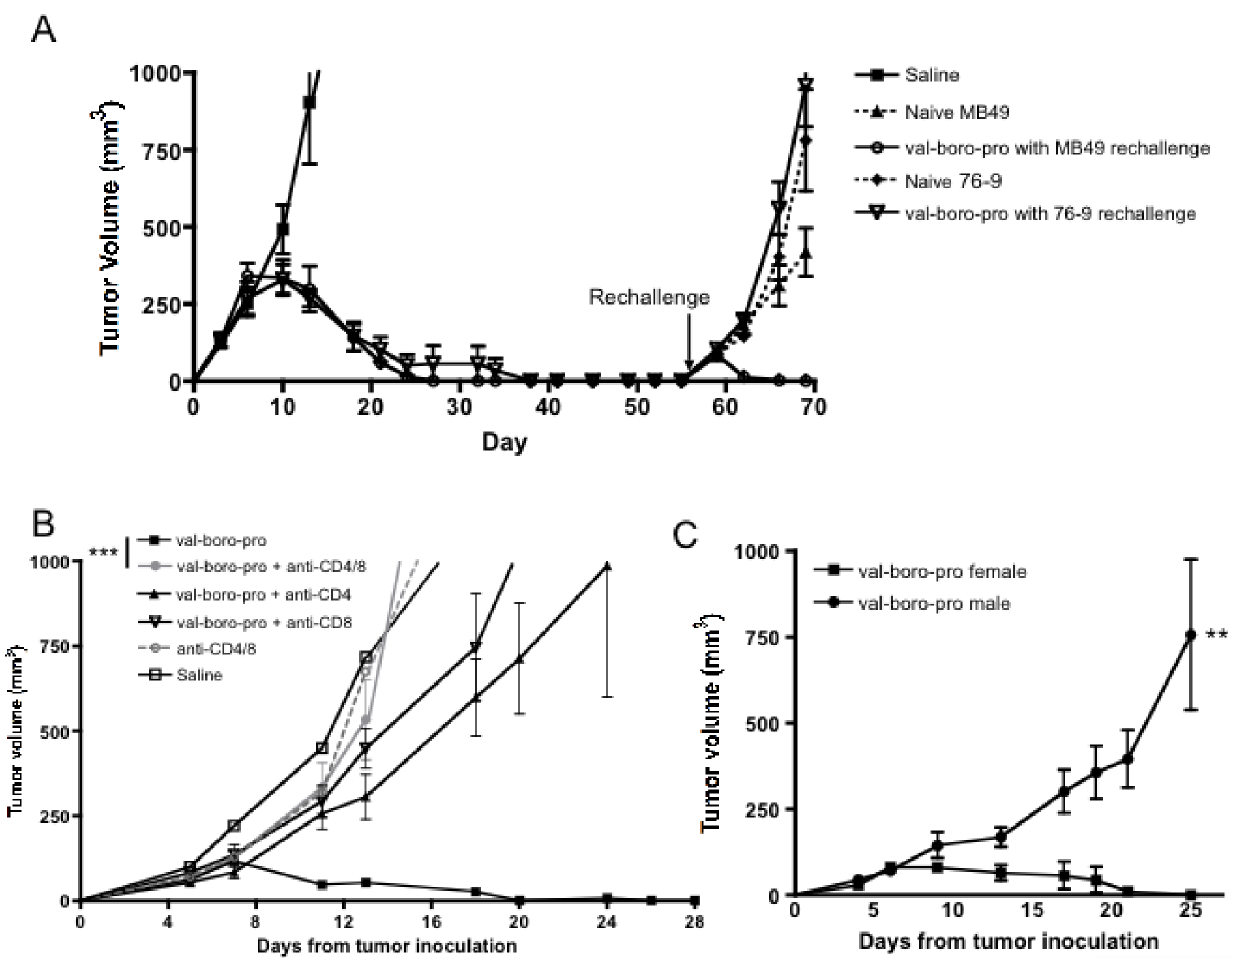
Figure 2. Val-boroPro mediated tumor regression is T cell dependent. (A) Female C57BL/6 mice were challenged on day 0 with 1 6 10 6 MB49 and treated with 20 m g Val-boroPro during weeks 1 through 4 (5 6 per week). Mice that were treated with 20 m g Val-boroPro and subsequently rejected MB49 were then rechallenged with MB49 (1 6 10 6 ) or 76-9 rhabdomyosarcoma (5 6 10 5 ) on day 56 post-primary challenge (n=5/group). Saline control, initial treatment (closed squares), naı¨ve mice (that did not previously reject tumors) injected with MB49 (closed triangles) or 76-9 (closed diamonds) at time of rechallenge, mice that previously rejected MB49 during Val-boroPro and rechallenged with MB49 (open circles) or 76-9 (inverted open triangles). (B) Mice were inoculated with MB49 as in Figure 1A and treated with Val-boroPro or saline (closed squares) (n=5/group). CD4 + and/ or CD8 + T cells were depleted with anti-CD4 and/or anti-CD8 monoclonal antibodies as outlined in methods. Tumor volumes in Val-boroPro treated mice without T cell depletion (closed squares) were significantly smaller than either CD4 (closed triangles) or CD8 (inverted open triangles) depleted groups (p , 0.05) and CD4/CD8 depleted group (closed circles) (p , 0.001) Open circles represent anti-CD4/anti-CD8 without Val-boroPro treatment. (C) Male (closed circles) and female (closed squares) mice were challenged subcutaneously with 10 6 HY-expressing tumor MB49 on day 0 and were treated with 20 m g Val-boroPro 5 6 /week for two weeks (n=5/group). P , 0.01 for all timepoints beyond day 15. Figures 2A–C are representative of 3